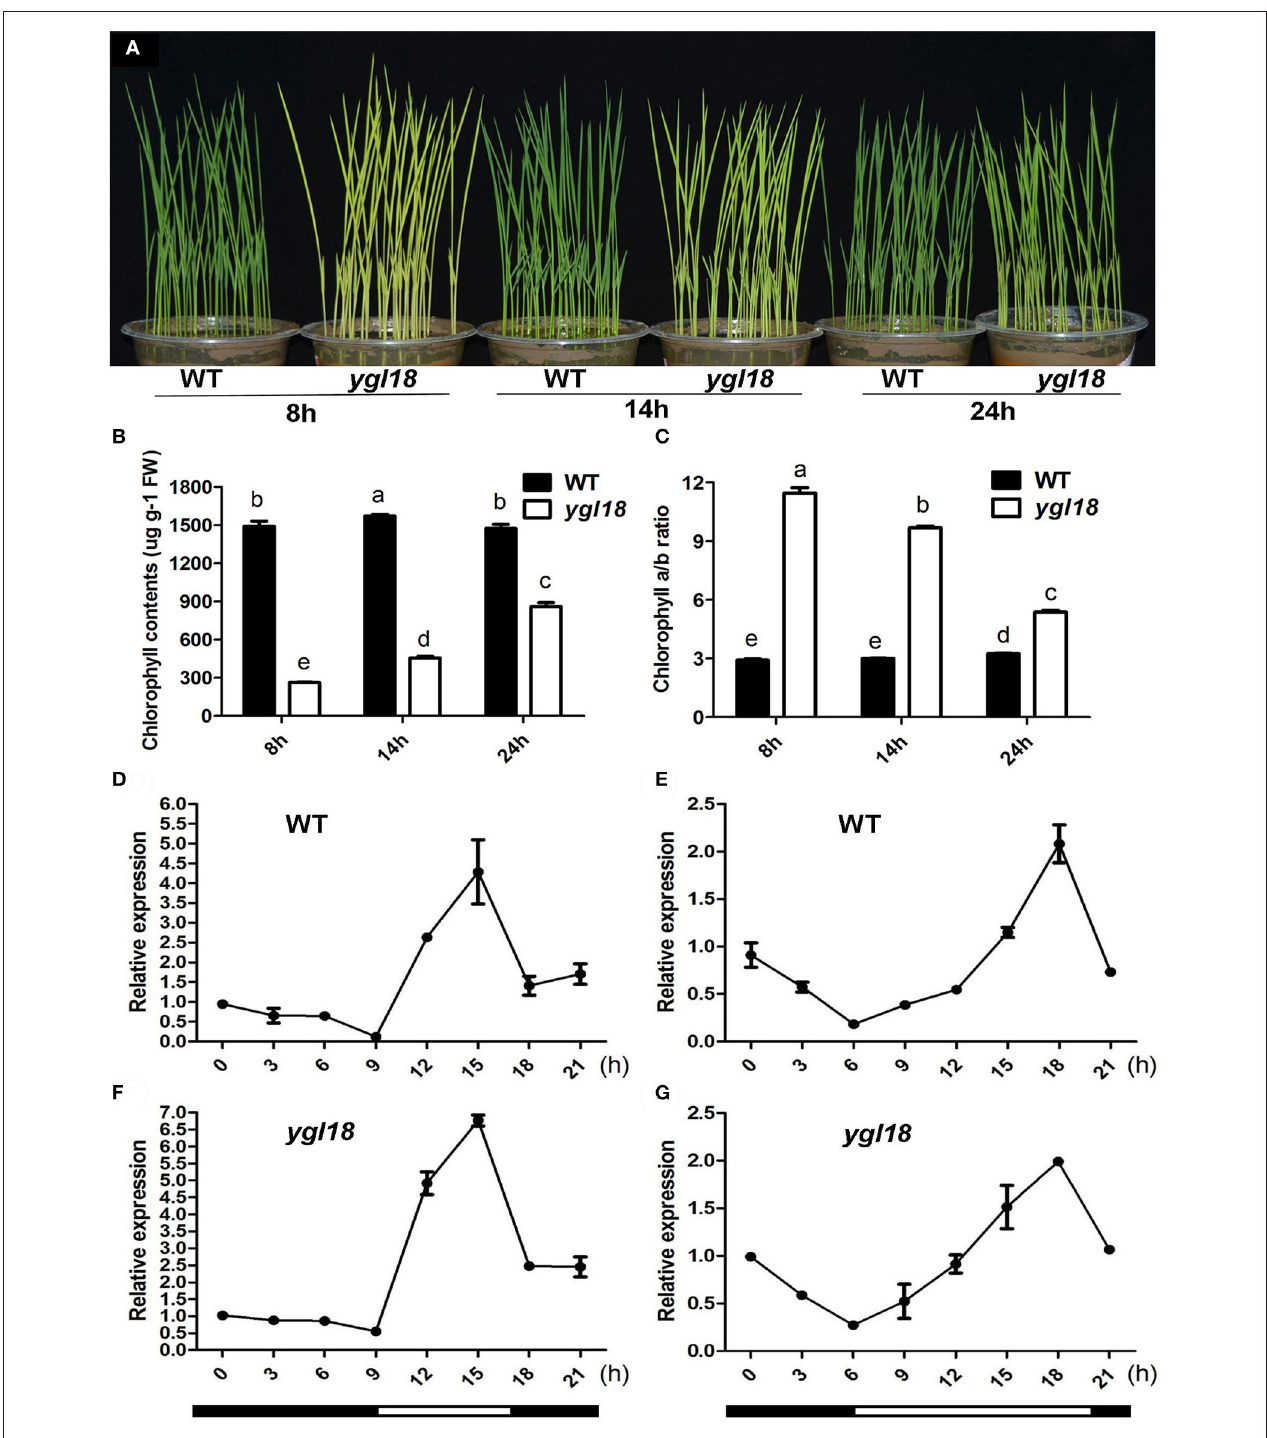
FIGURE 9 | Photoperiod-dependent chlorophyll synthesis in ygl18 leaves. (A) Leaf phenotypes of the 12-day-old wild-type and ygl18 seedlings under short-day (8h), long-day (14h) and continuous (24h) light conditions. (B) Chlorophyll contents of plant leaves in (A) . FW, fresh weight. (C) Chlorophyll a / b ratio of the plant leaves in (A) . In (B,C) , data represent the mean ± SD of four biological replicates (one-way ANOVA analysis). (D–G) Daily expression patterns of YGL18 in the wild-type and ygl18 seedling leaves under the short-day ( D , F , 8h light: 9:00 to 17:00.) and the long-day conditions ( E , G , 14h light: 6:00 to 20:00.). Leaf samples were harvested at 3h intervals. Data represent the mean ± SD of two biological replicates. Different letters indicate values are statistically different based on a one-way ANOVA analysis.